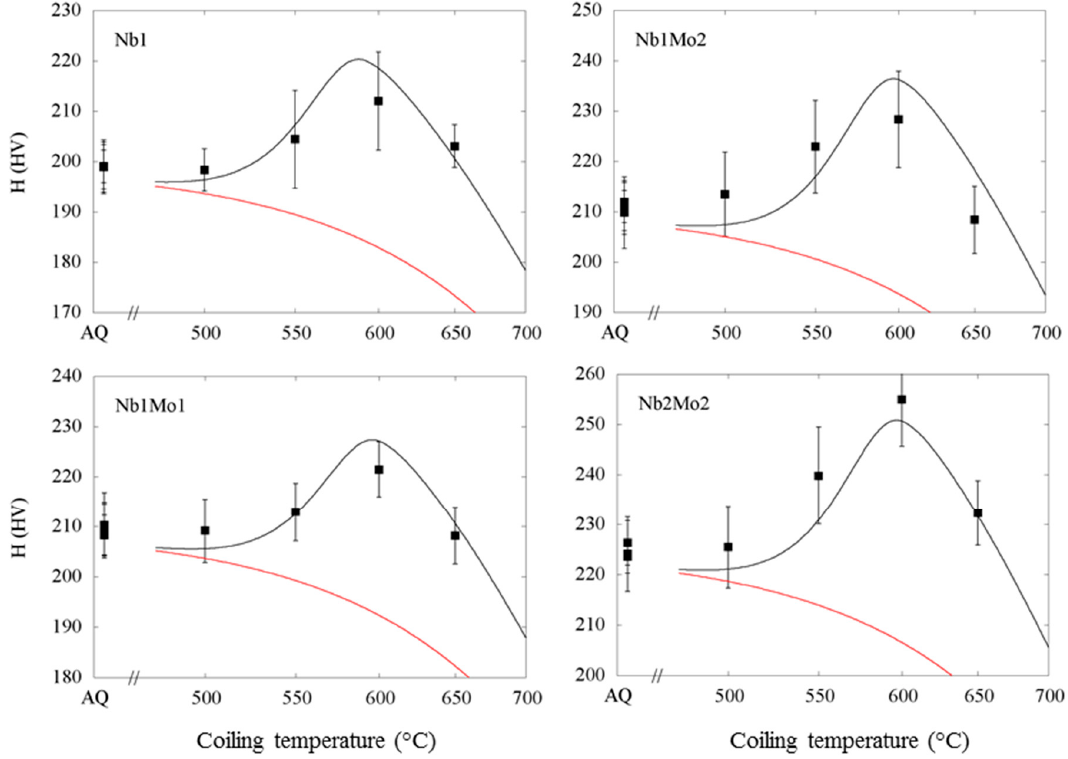
Figure 18. Comparison of measured (symbols) and predicted (solid lines) hardness of hardening after coiling as a function of coiling temperature for the four investigated steels, i.e., Nb1, Nb1Mo1, Nb1Mo2 and Nb2Mo2. The red curves represent the calculated microstructure hardness without precipitation strengthening contribution.